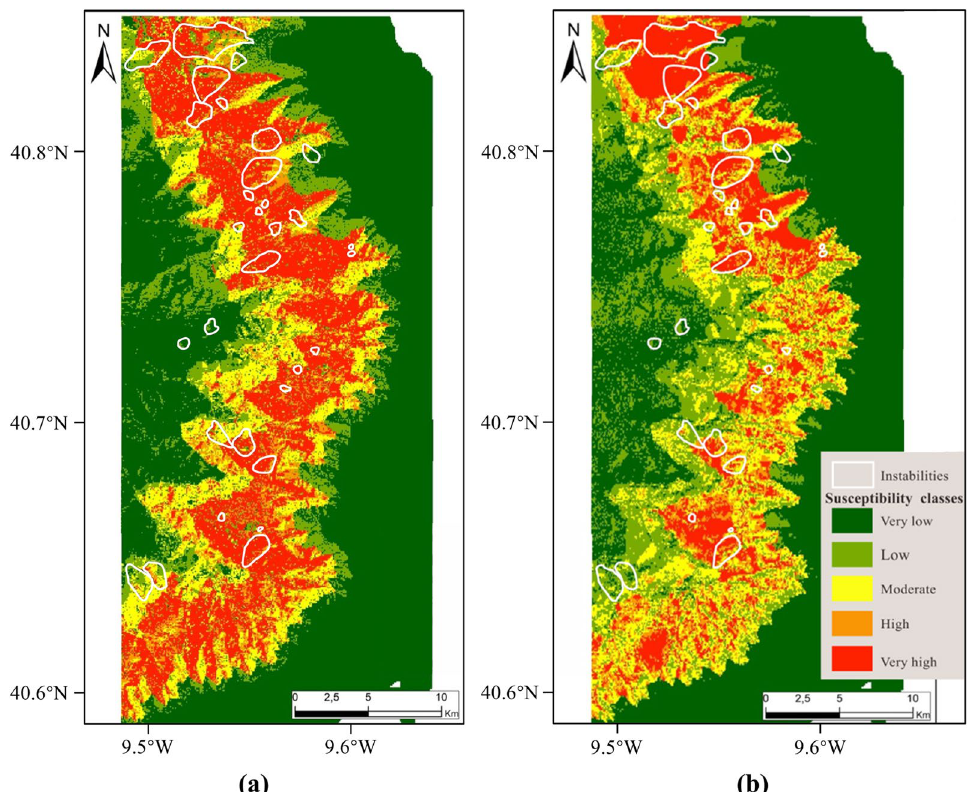
Fig. 24 Susceptibility maps with all factors based on different models: a information value (IV) model; b logistic regression (LR) model. White polygons correspond to the delimitations of the identified instabilities (modified from Lapa et al. 2020)